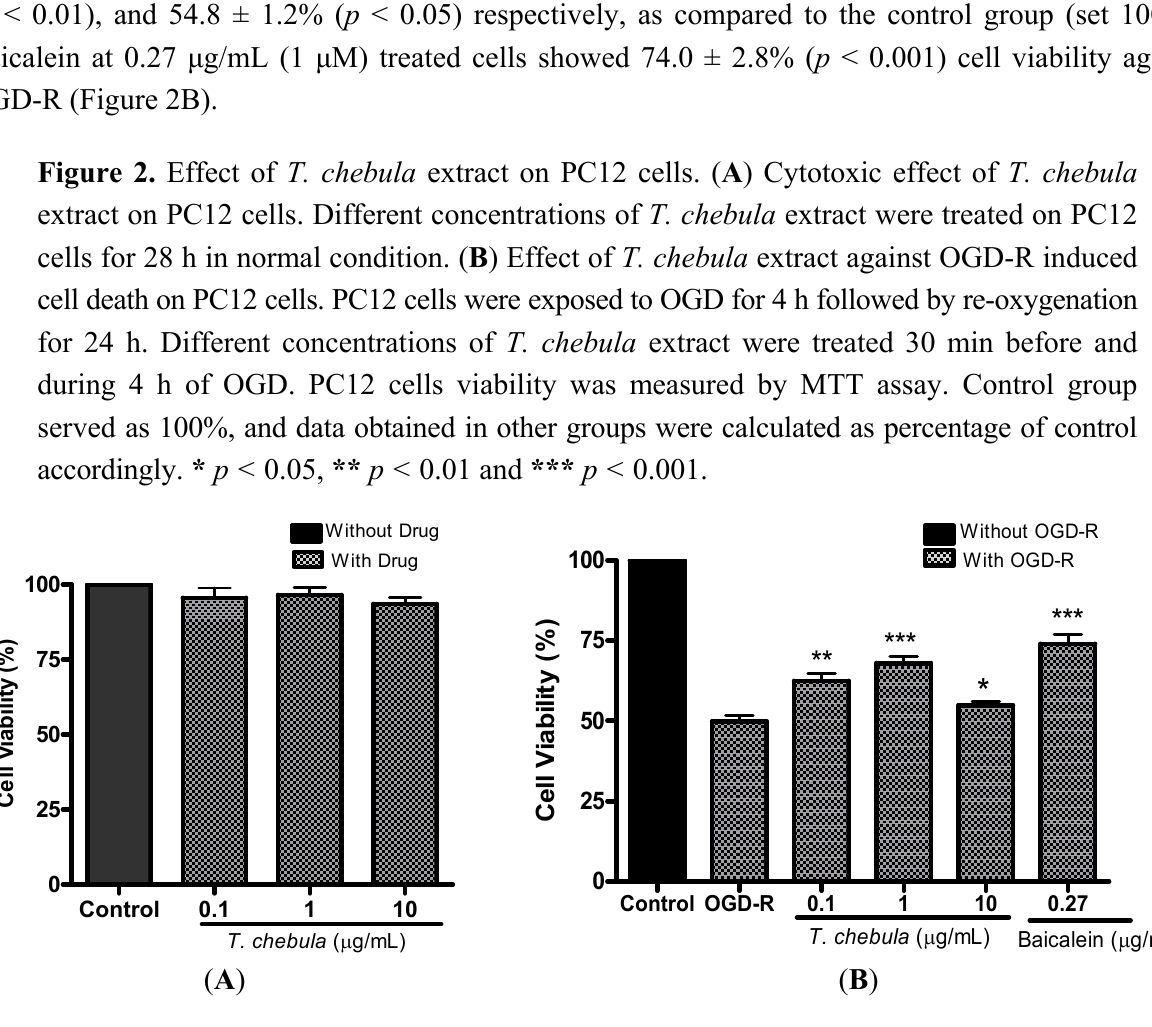
extract on PC12 cells. Different concentrations of T. chebula extract were treated on